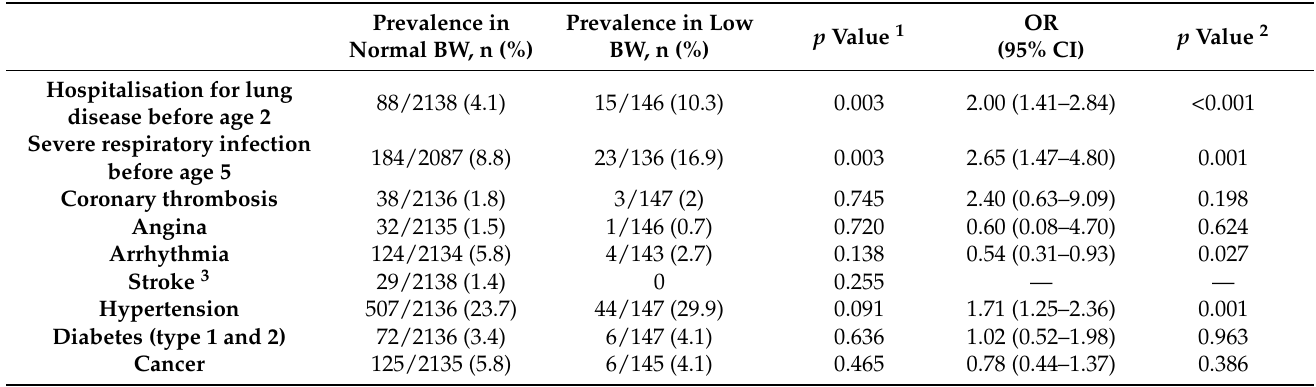
Table 6. Association between birthweight and respiratory conditions in childhood and non- respiratory diseases in